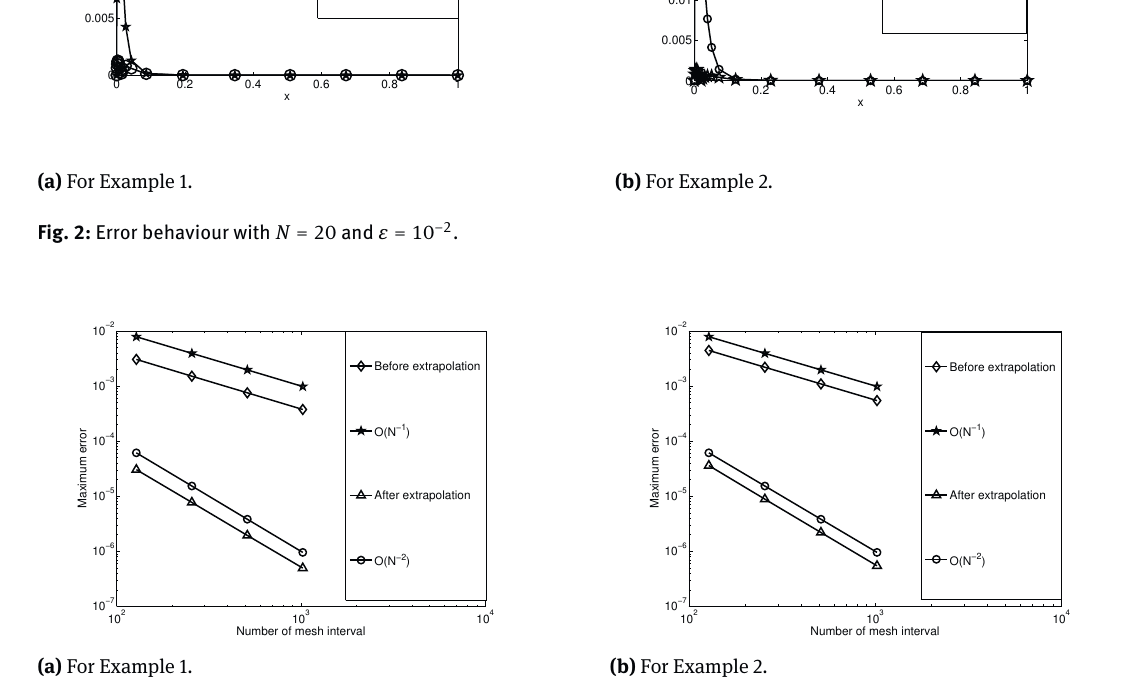
Fig. 3: Loglog plot of maximum point-wise errors with ε = 10 −8